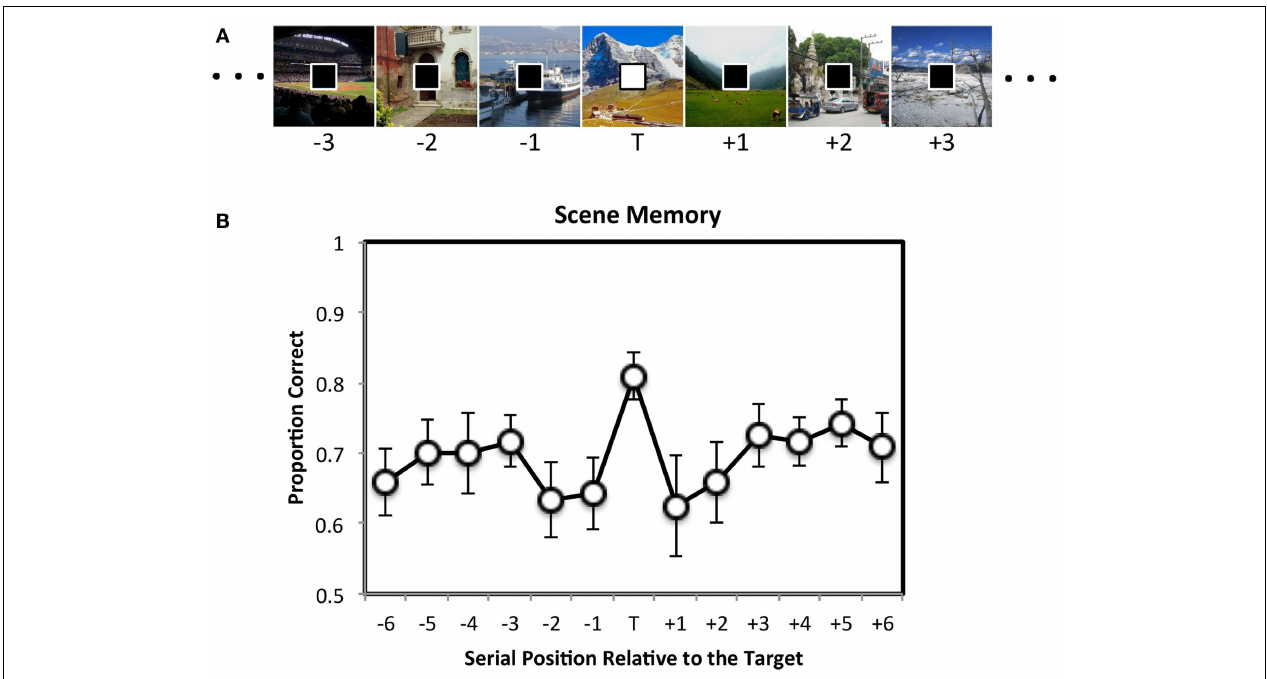
scale. (B) Later recognition memory for the scenes was enhanced if the scene was presented at the same time as a target square during encoding. Error bars =± 1 standard error of the mean. Adapted from Swallow and Jiang